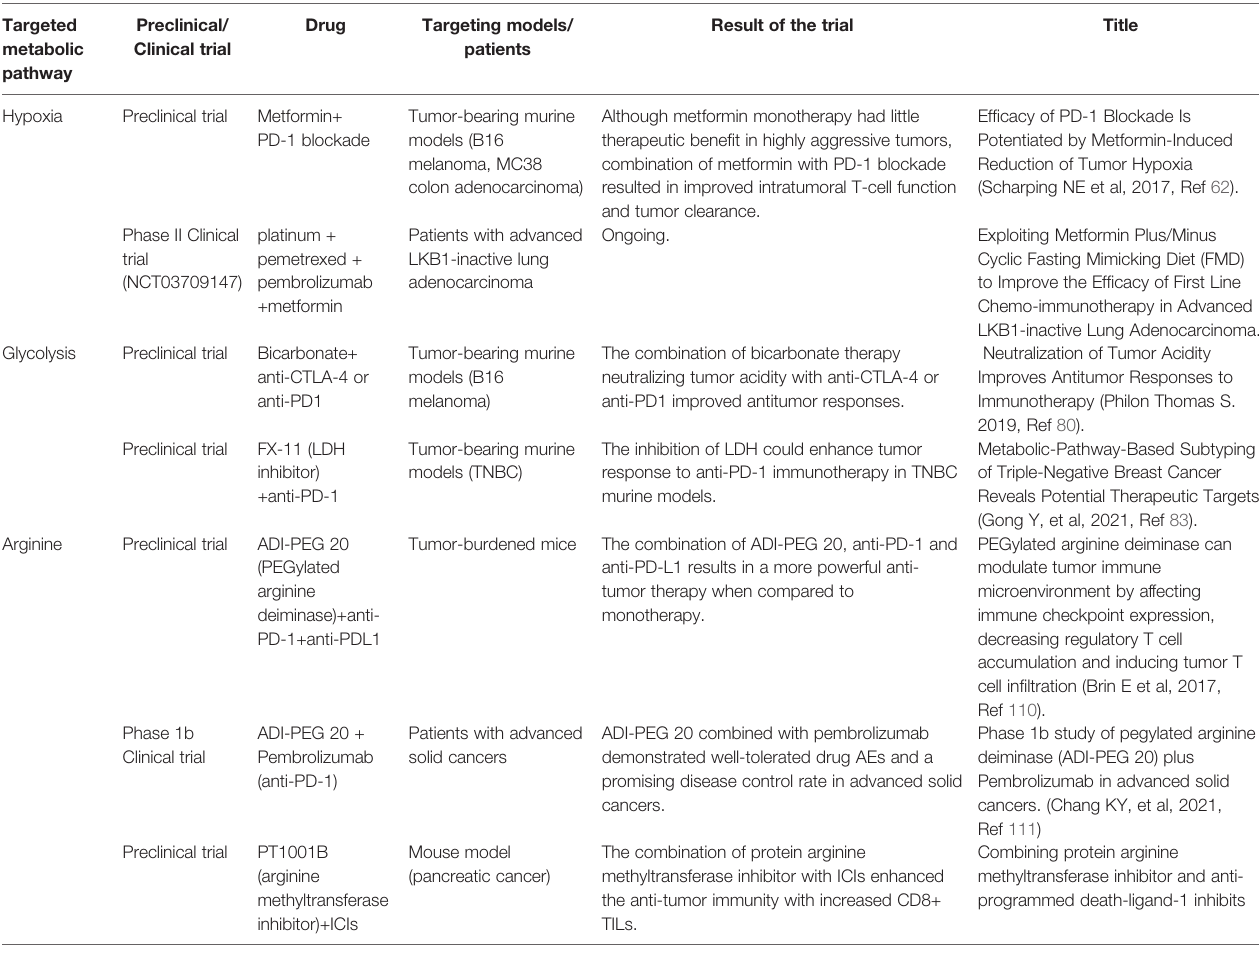
TABLE 3 | Preclinical and clinical trials of drugs inhibiting metabolic targets with ICIs in anti-tumor